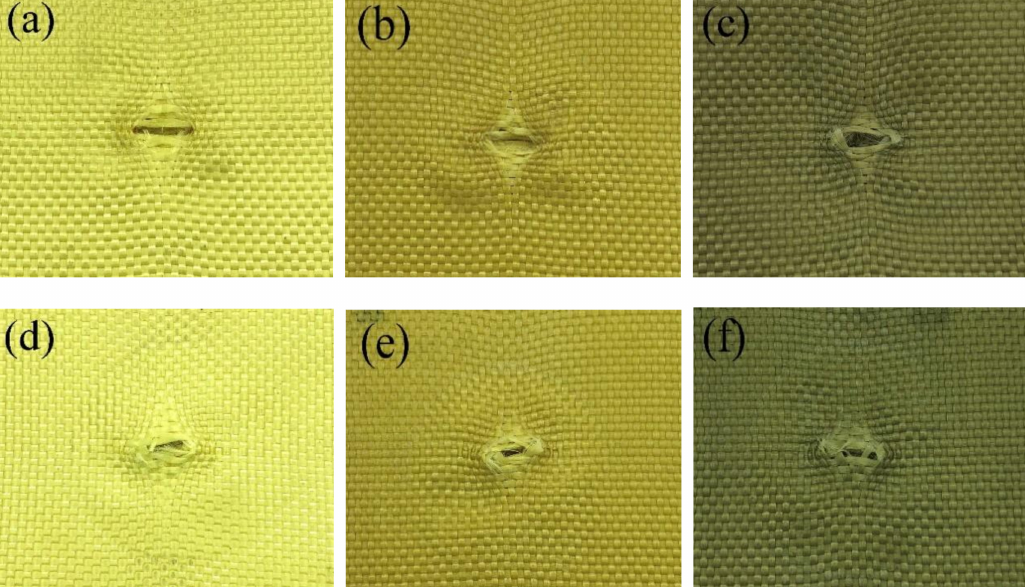
Figure 8. Front and rear view of samples after the quasi-static tests: ( a , d ) neat Kevlar fabric, ( b , e ) STF/Kevlar fabric, ( c , f ) M-MWNT/STF/Kevlar